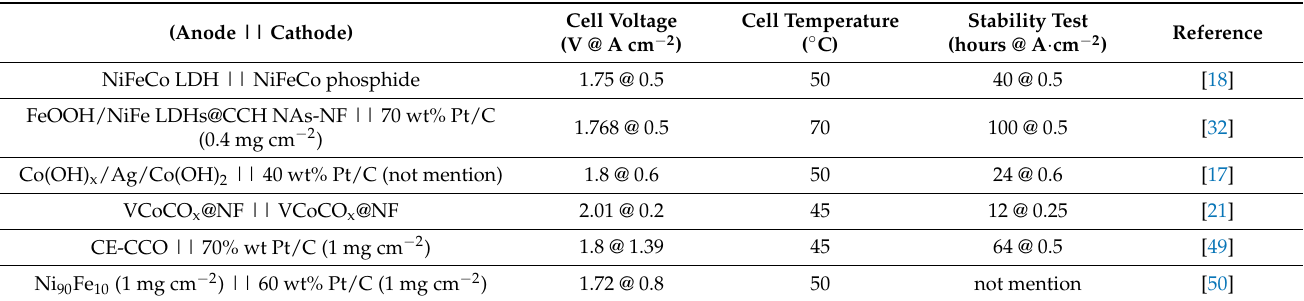
Table 2. Comparison of the AEMWE electrode performance 1 M